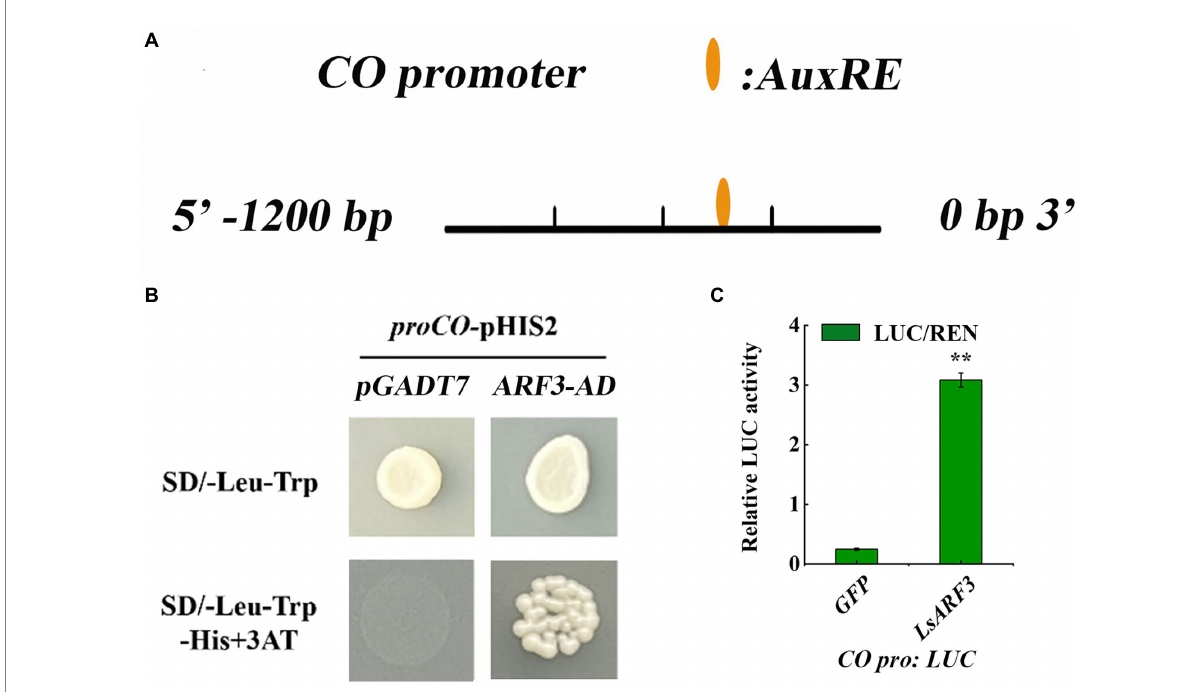
FIGURE 6 LsARF3 binds to the promoter of LsCO by Yeast one-Hybrid (Y1H) assay. (A) The AuxRE element in the promoter of LsCO gene. (B) Yeast one- hybrid (Y1H) experiment showing the binding of LsARF3 -AD to the promoter of LsCO . (C) Dual luciferase reporter assay. The GFP effector was used as a negative control, and the LUC/REN ratios of GFP were set as 1. Significant differences were tested by Student’s t -test (*indicates p <